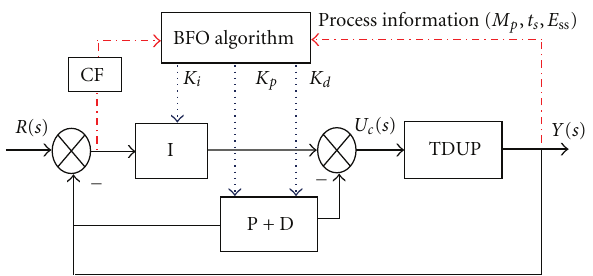
Figure 6: BFO-based I-PD controller